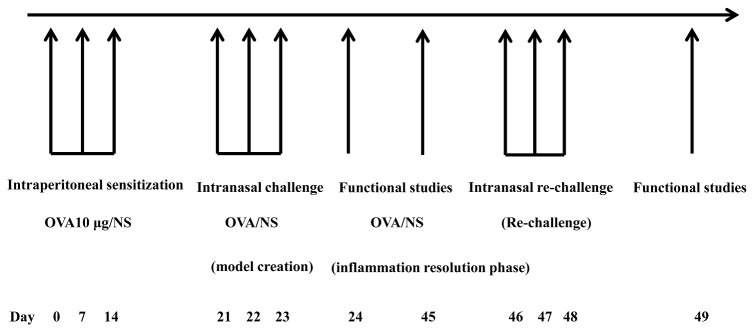
The study flow chart.